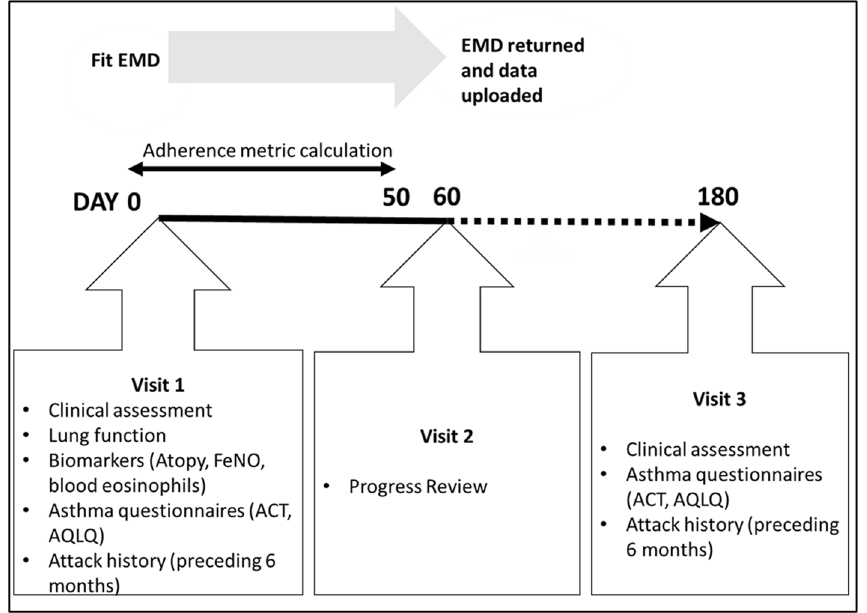
Figure 1. Assessment protocol timeline, visits and clinical measures. EMD electronic monitoring device, ACT asthma control test, AQLQ asthma quality of life. (Microsoft Powerpoint, version 2101, https:// office. live. com/ start/ power point.